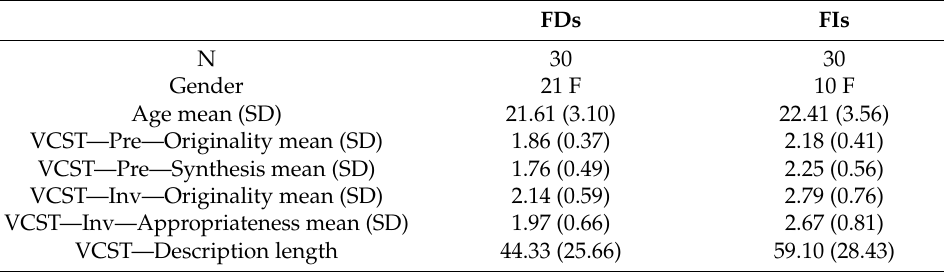
Table 1. Descriptive statistics divided by FDI